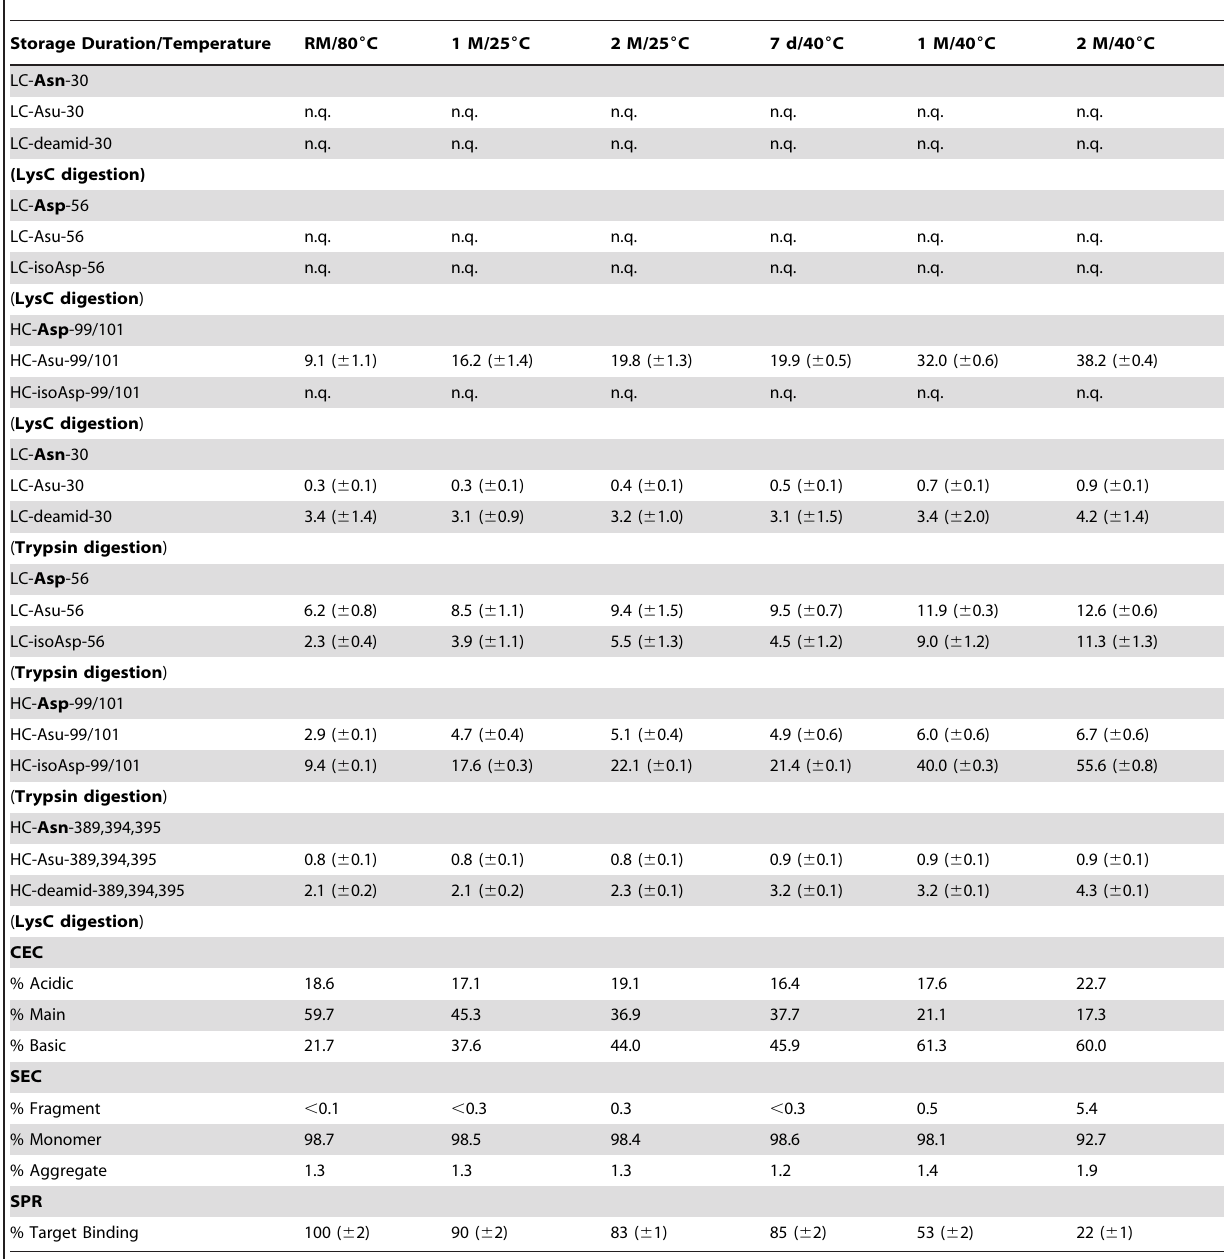
Table 3. Identification and evaluation of Mab1 Asn deamidation and Asp isomerization sites using accelerated degradation conditions and quantitative UPLC-MS (Procedure